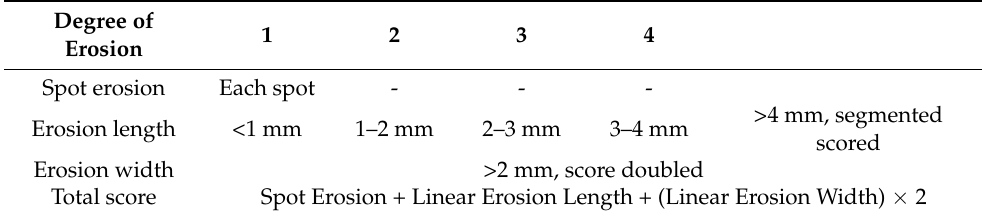
Table 2. Scoring criteria for gastric ulcer